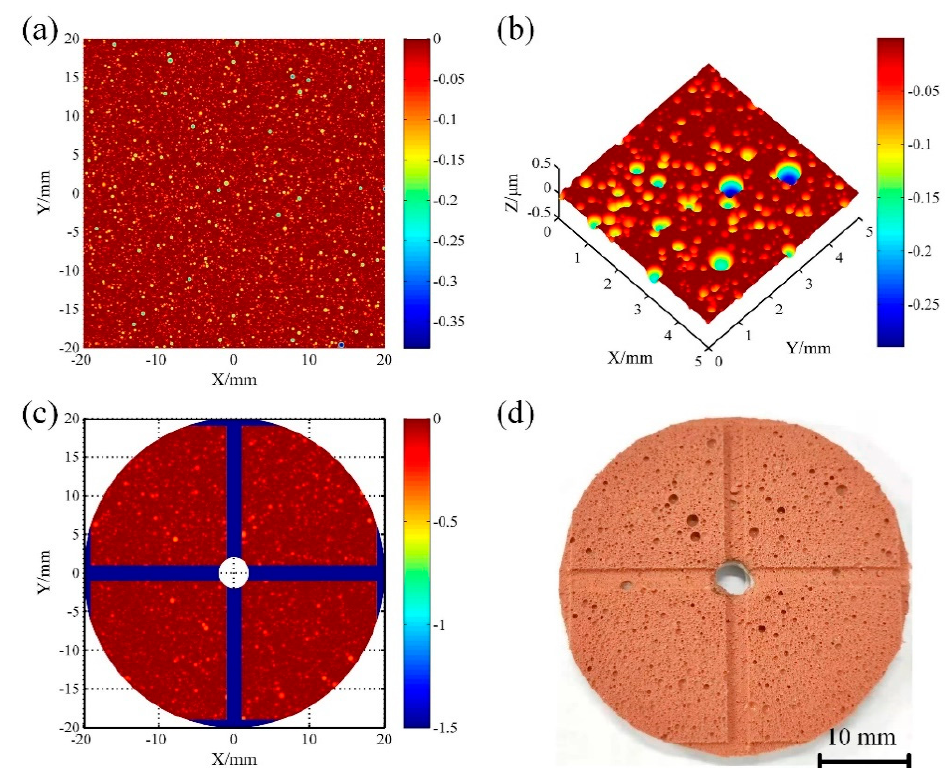
Figure 6. Simulation of surface morphology of polishing pad: ( a ) surface pore distribution, ( b ) micropore characteristics, ( c ) surface morphology of polishing pad with diameter of 40 mm, ( d ) actual photo of polishing pad.